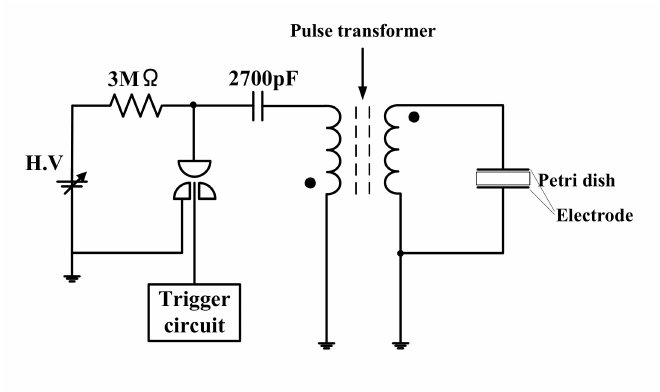
Figure 2. Pulsed plasma generating